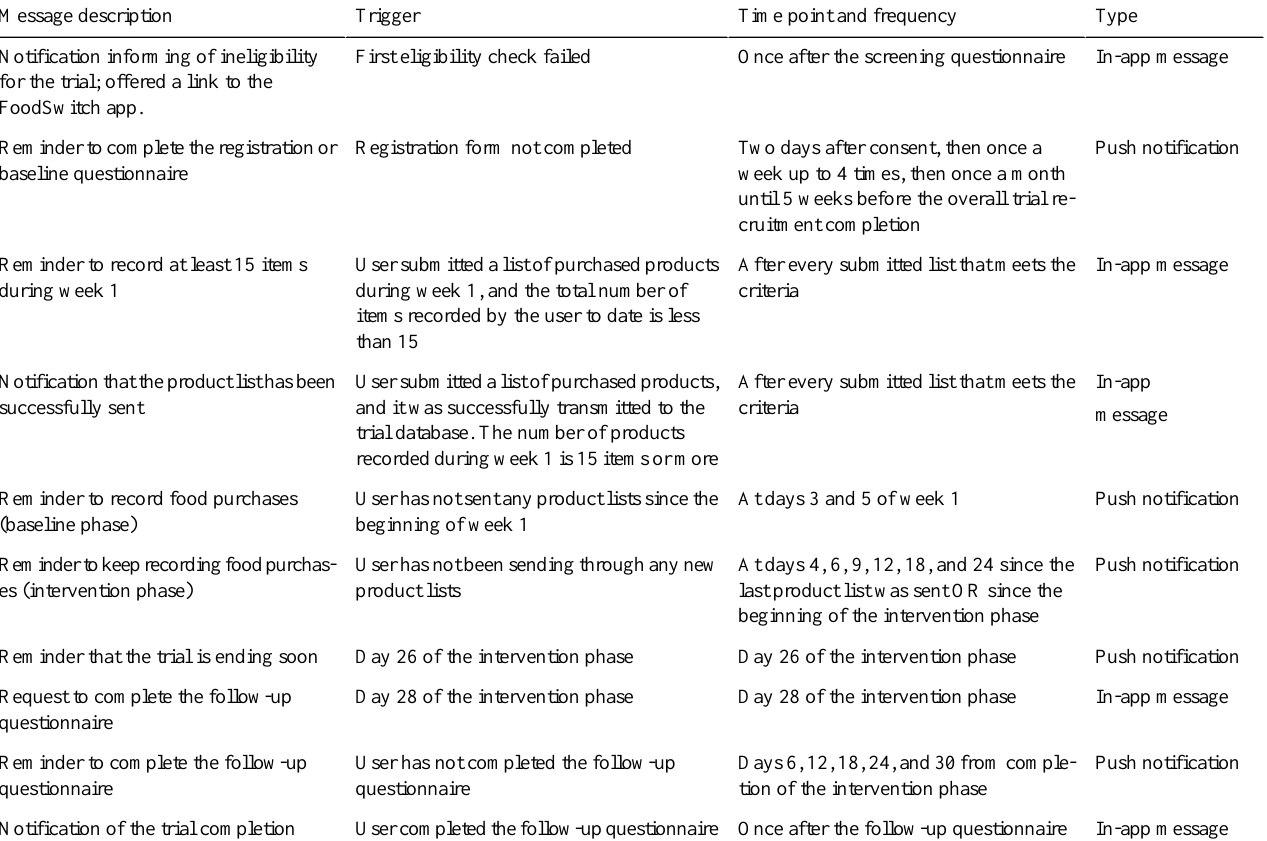
TypeTime point and frequencyTriggerMessage